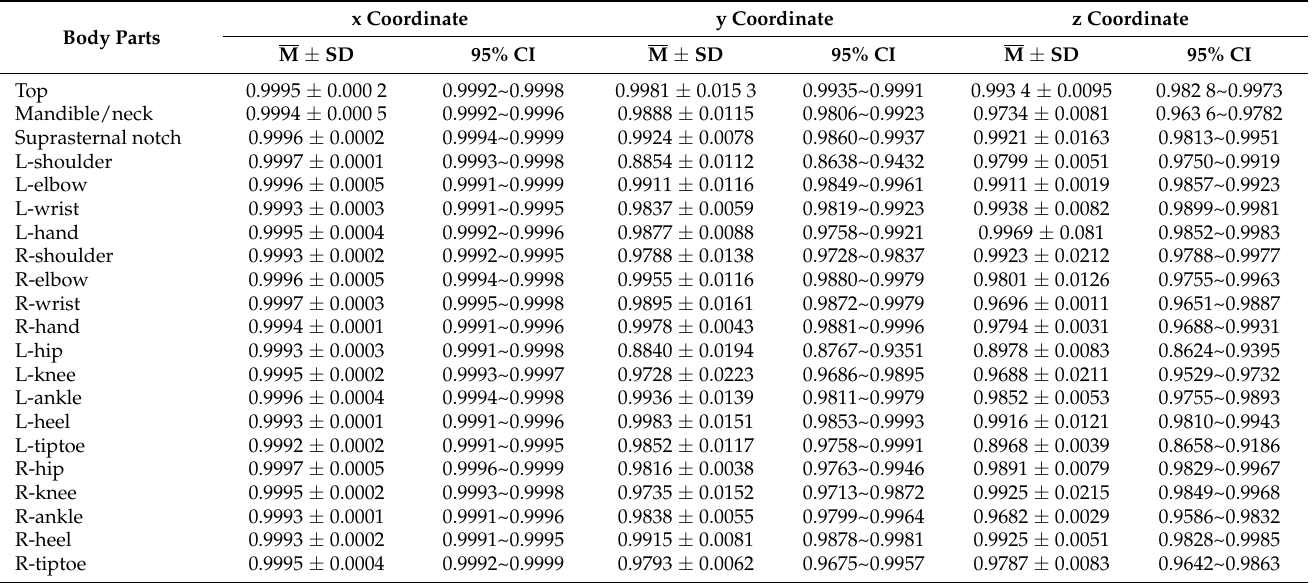
Table 3. Multiple correlation coefficients of human joint point coordinate–time average curve obtained via automatic analysis and manual